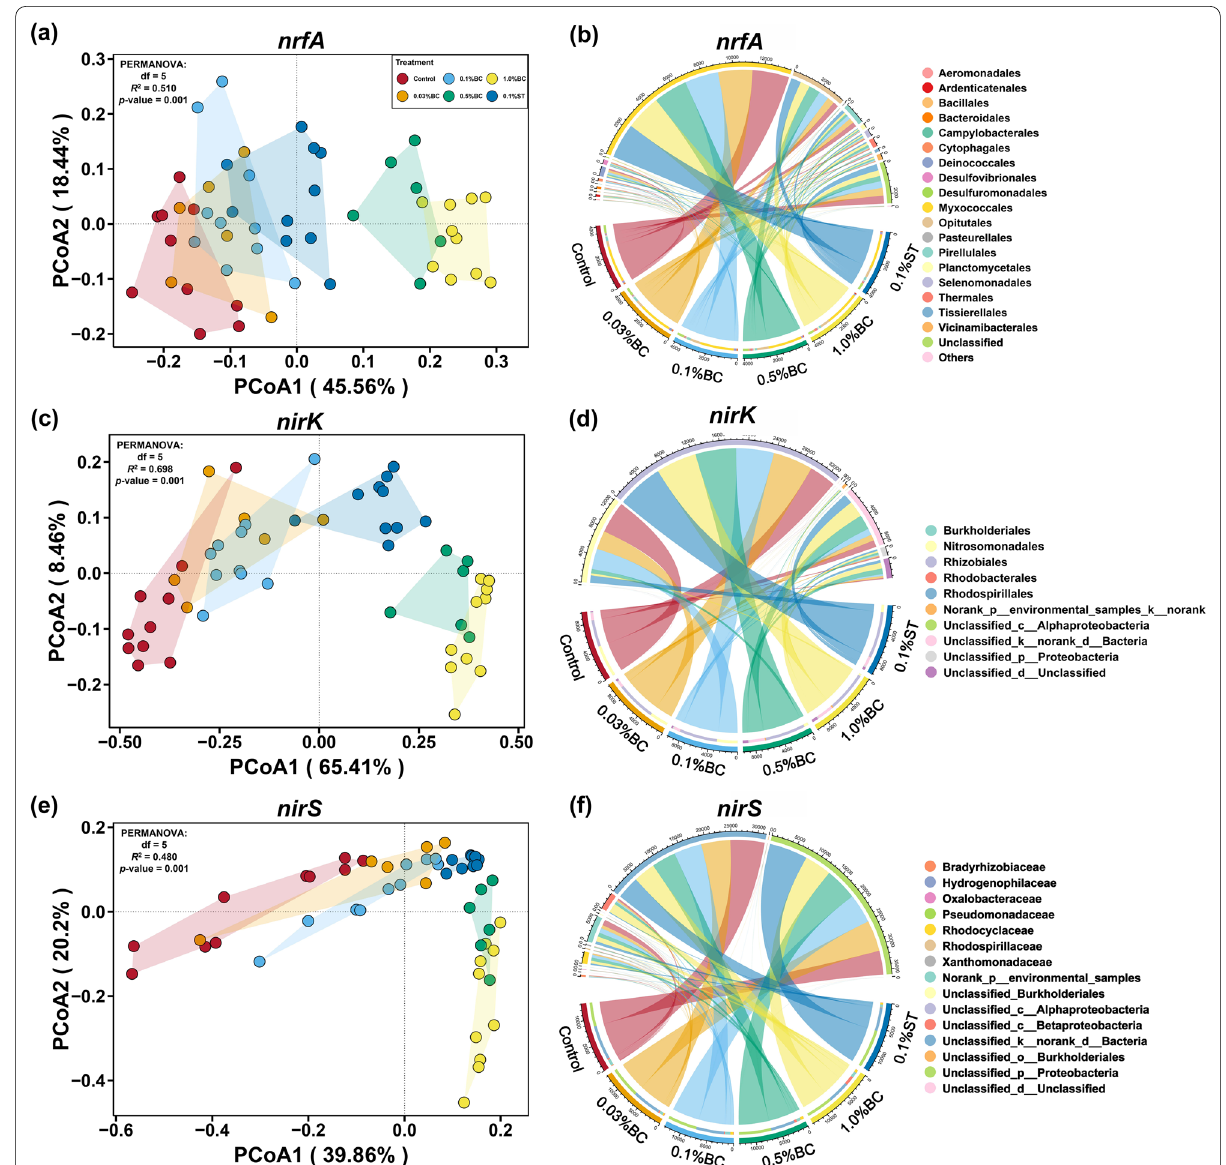
Fig. 3 Nitrate reducers in the Control, 0.03%BC, 0.1%BC, 0.5%BC, 1.0%BC, and 0.1%ST treatments. Unconstrained principal coordinate analysis (PCoA) shows that soils amended with different amounts of biochar (0%, 0.03%, 0.1%, 0.5%, and 1.0% rates) or straw at 0.1% rate have significantly distinct microbiota, as suggested by permutational multivariate analysis of variance (PERMANOVA): nitrate reducers encoded by the nrfA ( a ), nirK ( c ), and nirS ( e ) genes. Circos plots show the composition of nrfA ( b ), nirK ( d ), and nirS - ( f ) encoding nitrate reducer communities at the order level in each